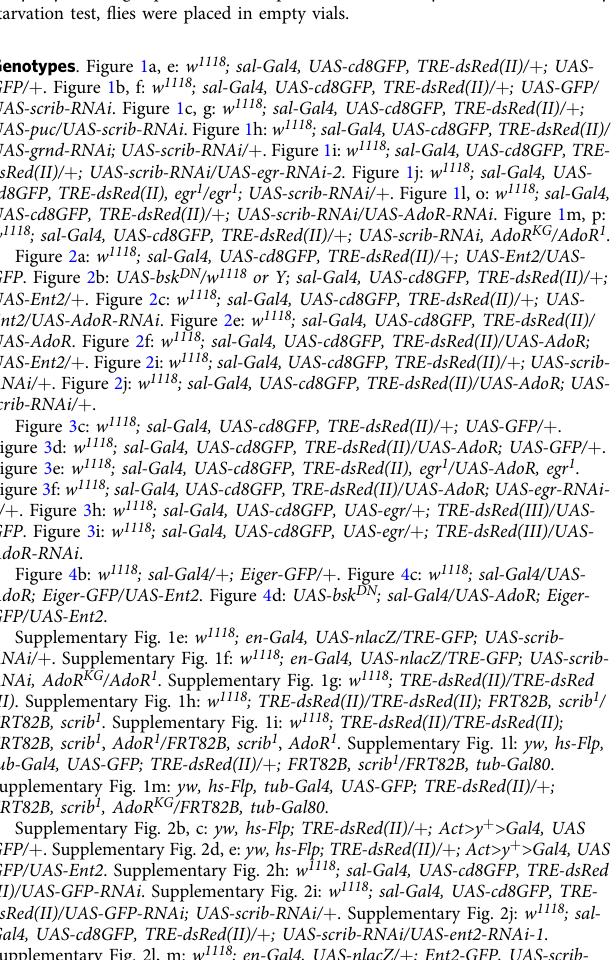
cd8GFP, TRE-dsRed(II), egr 1 /egr 1 ; UAS-scrib-RNAi/ + . Figure 1l, o: w 1118 ; sal-Gal4, UAS-cd8GFP, TRE-dsRed(II)/ + ; UAS-scrib-RNAi/UAS-AdoR-RNAi . Figure 1m, p: w 1118 ; sal-Gal4, UAS-cd8GFP, TRE-dsRed(II)/ + ; UAS-scrib-RNAi, AdoR KG /AdoR 1 . Figure 2a: w 1118 ; sal-Gal4, UAS-cd8GFP, TRE-dsRed(II)/ + ; UAS-Ent2/UAS- GFP . Figure 2b: UAS-bsk DN /w 1118 or Y; sal-Gal4, UAS-cd8GFP, TRE-dsRed(II)/ + ; UAS-Ent2/ + . Figure 2c: w 1118 ; sal-Gal4, UAS-cd8GFP, TRE-dsRed(II)/ + ; UAS- Ent2/UAS-AdoR-RNAi . Figure 2e: w 1118 ; sal-Gal4, UAS-cd8GFP, TRE-dsRed(II)/ UAS-AdoR . Figure 2f: w 1118 ; sal-Gal4, UAS-cd8GFP, TRE-dsRed(II)/UAS-AdoR; UAS-Ent2/ + . Figure 2i: w 1118 ; sal-Gal4, UAS-cd8GFP, TRE-dsRed(II)/ + ; UAS-scrib- RNAi/ + . Figure 2j: w 1118 ; sal-Gal4, UAS-cd8GFP, TRE-dsRed(II)/UAS-AdoR; UAS- scrib-RNAi/ + . Figure 3c: w 1118 ; sal-Gal4, UAS-cd8GFP, TRE-dsRed(II)/ + ; UAS-GFP/ + . Figure 3d: w 1118 ; sal-Gal4, UAS-cd8GFP, TRE-dsRed(II)/UAS-AdoR; UAS-GFP/ + . Figure 3e: w 1118 ; sal-Gal4, UAS-cd8GFP, TRE-dsRed(II), egr 1 /UAS-AdoR, egr 1 . Figure 3f: w 1118 ; sal-Gal4, UAS-cd8GFP, TRE-dsRed(II)/UAS-AdoR; UAS-egr-RNAi- 2/ + . Figure 3h: w 1118 ; sal-Gal4, UAS-cd8GFP, UAS-egr/ + ; TRE-dsRed(III)/UAS- GFP . Figure 3i: w 1118 ; sal-Gal4, UAS-cd8GFP, UAS-egr/ + ; TRE-dsRed(III)/UAS- AdoR-RNAi . Figure 4b: w 1118 ; sal-Gal4/ + ; Eiger-GFP/ + . Figure 4c: w 1118 ; sal-Gal4/UAS- AdoR; Eiger-GFP/UAS-Ent2 . Figure 4d: UAS-bsk DN ; sal-Gal4/UAS-AdoR; Eiger- GFP/UAS-Ent2 . Supplementary Fig. 1e: w 1118 ; en-Gal4, UAS-nlacZ/TRE-GFP; UAS-scrib- RNAi/ + . Supplementary Fig. 1f: w 1118 ; en-Gal4, UAS-nlacZ/TRE-GFP; UAS-scrib- RNAi, AdoR KG /AdoR 1 . Supplementary Fig. 1g: w 1118 ; TRE-dsRed(II)/TRE-dsRed (II) . Supplementary Fig. 1h: w 1118 ; TRE-dsRed(II)/TRE-dsRed(II); FRT82B, scrib 1 / FRT82B, scrib 1 . Supplementary Fig. 1i: w 1118 ; TRE-dsRed(II)/TRE-dsRed(II); FRT82B, scrib 1 , AdoR 1 /FRT82B, scrib 1 , AdoR 1 . Supplementary Fig. 1l: yw, hs-Flp, tub-Gal4, UAS-GFP; TRE-dsRed(II)/ + ; FRT82B, scrib 1 /FRT82B, tub-Gal80 . Supplementary Fig. 1m: yw, hs-Flp, tub-Gal4, UAS-GFP; TRE-dsRed(II)/ + ; FRT82B, scrib 1 , AdoR KG /FRT82B, tub-Gal80 . Supplementary Fig. 2b, c: yw, hs-Flp; TRE-dsRed(II)/ + ; Act>y + >Gal4, UAS GFP/ + . Supplementary Fig. 2d, e: yw, hs-Flp; TRE-dsRed(II)/ + ; Act>y + >Gal4, UAS GFP/UAS-Ent2 . Supplementary Fig. 2h: w 1118 ; sal-Gal4, UAS-cd8GFP, TRE-dsRed (II)/UAS-GFP-RNAi . Supplementary Fig. 2i: w 1118 ; sal-Gal4, UAS-cd8GFP, TRE- dsRed(II)/UAS-GFP-RNAi; UAS-scrib-RNAi/ + . Supplementary Fig. 2j: w 1118 ; sal- Gal4, UAS-cd8GFP, TRE-dsRed(II)/ + ; UAS-scrib-RNAi/UAS-ent2-RNAi-1 . Supplementary Fig. 2l, m: w 1118 ; en-Gal4, UAS-nlacZ/ + ; Ent2-GFP, UAS-scrib- RNAi/TRE-dsRed(III) . Supplementary Fig. 2n: w 1118 ; Ent2-GFP/Ent2-GFP . Supplementary Fig. 2o: w 1118 ; en-Gal4, UAS-nlacZ/ + ; AdoR-GFP, UAS-scrib-RNAi/ TRE-dsRed(III) . Supplementary Fig. 2p, q: w 1118 ; en-Gal4, UAS-nlacZ/UAS-AdoR; UAS-Ent2/ + .